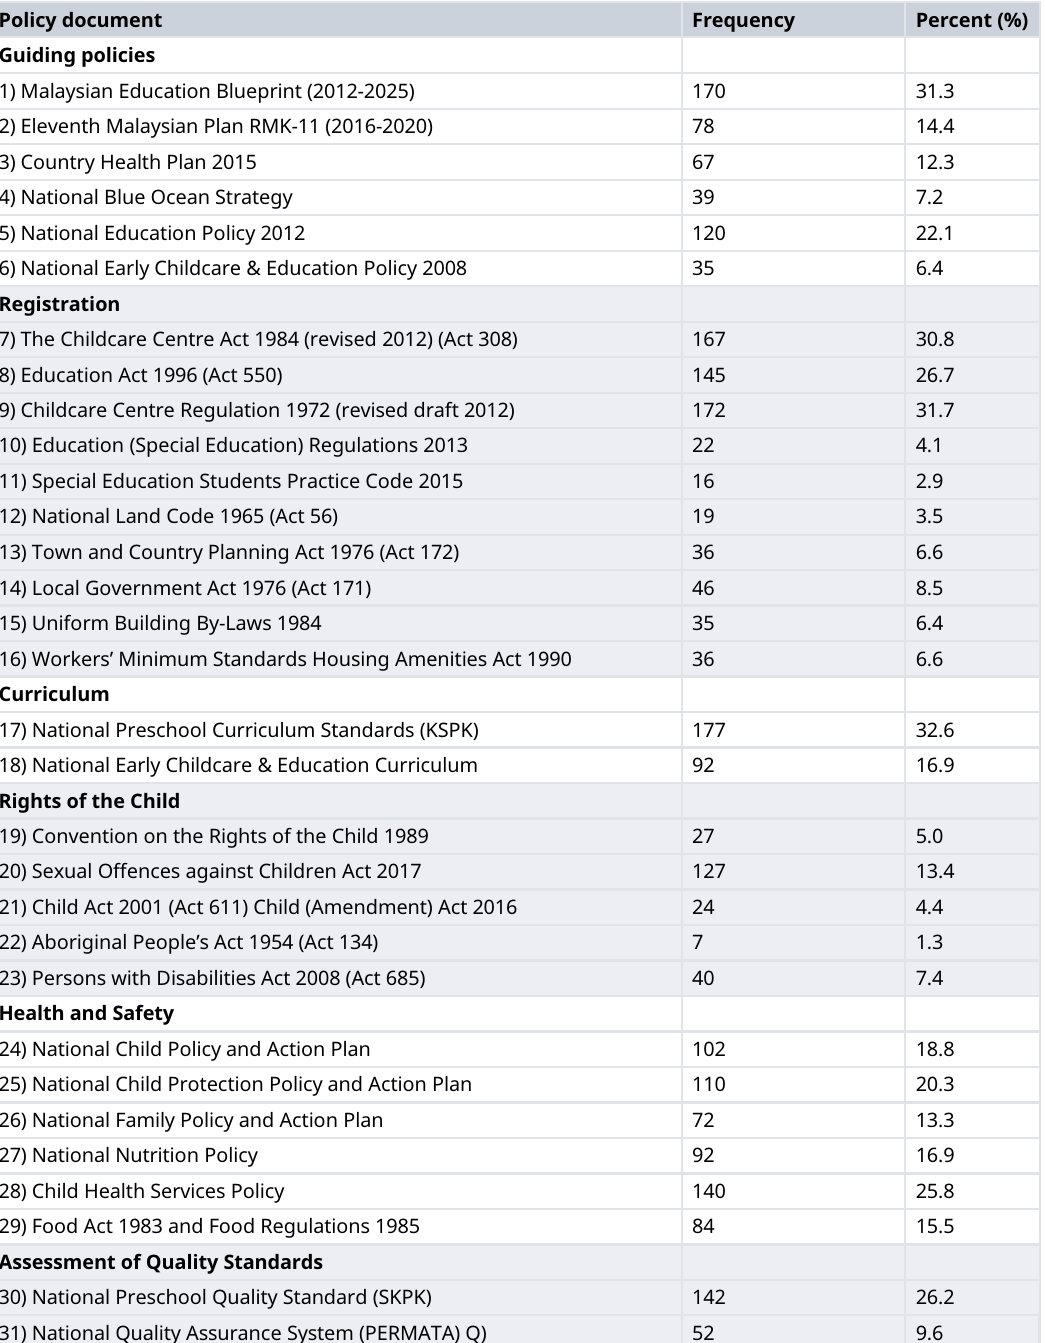
Table 3. Parents ’ views on the importance of policy. Policy document Frequency Percent (%) Guiding